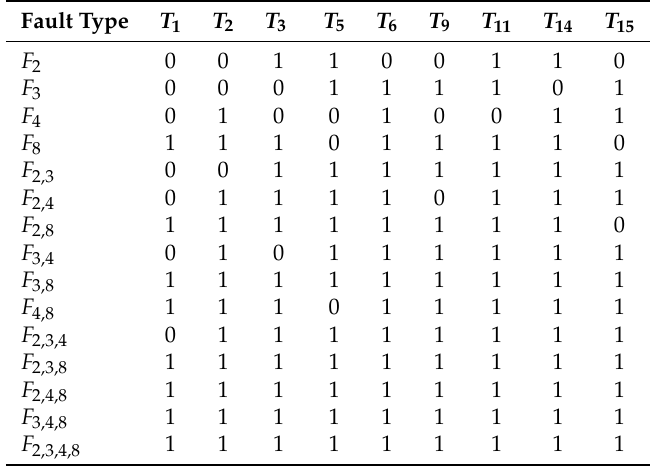
Table 12. Multiple fault dependency matrix of the system in Experiment 2.